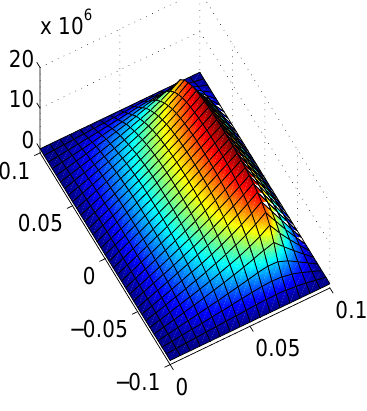
Figure 2. Homogenized pressure distribution with a non- Newtonian